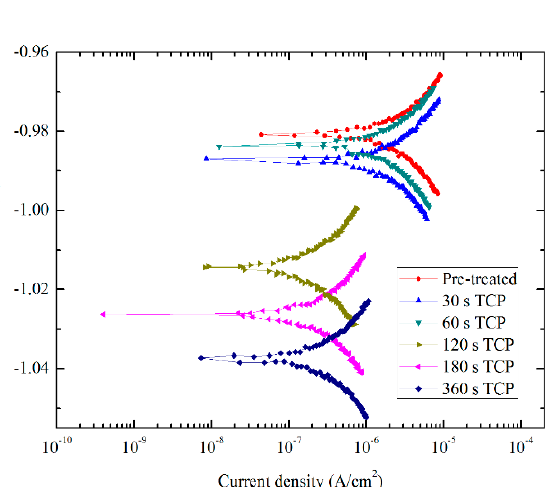
Figure 8. Linear polarization curves of TCCs with different treatment times in aerated 0.5 M NaCl solution.